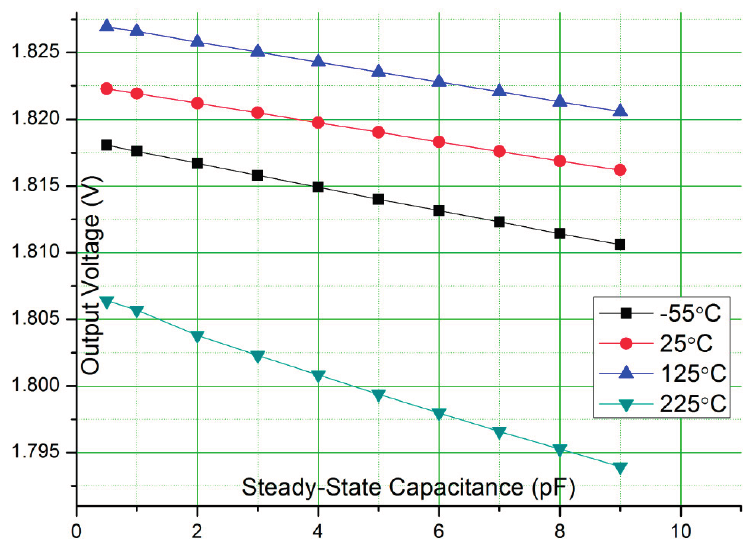
Figure 8. Simulated output voltage for different steady-state